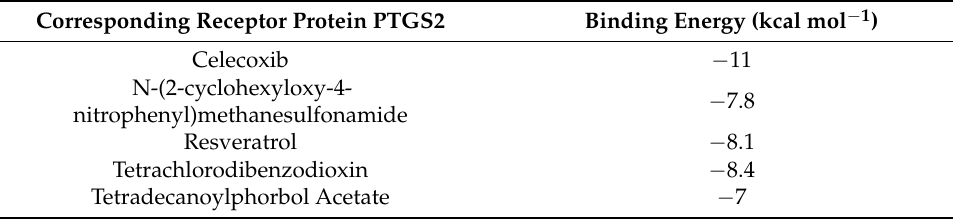
Table 5. Drugs that interacted with